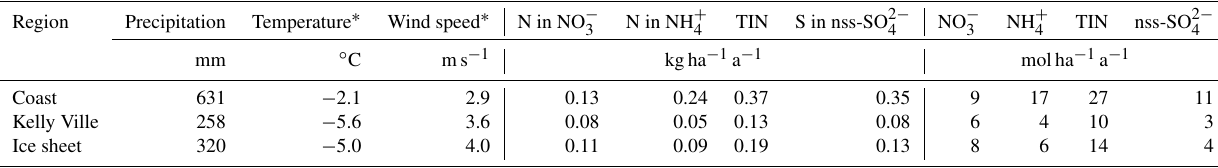
Table 6. Mean annual meteorological data and deposition estimates based on snowpack chemistry and mean precipitation (2001–2012) for Sisimiut (coast), Kangerlussuaq and SS903 at the ice sheet margin (Johansson et al., 2015; Mernild et al., 2015). Region